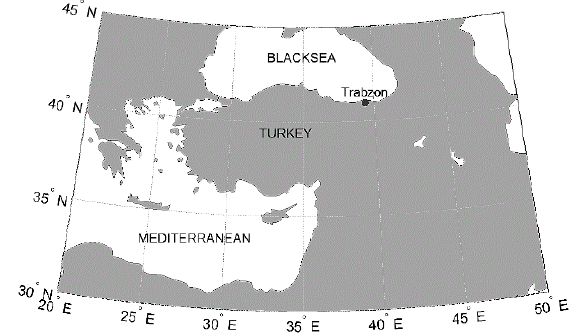
Figure 4. Location of the study area in